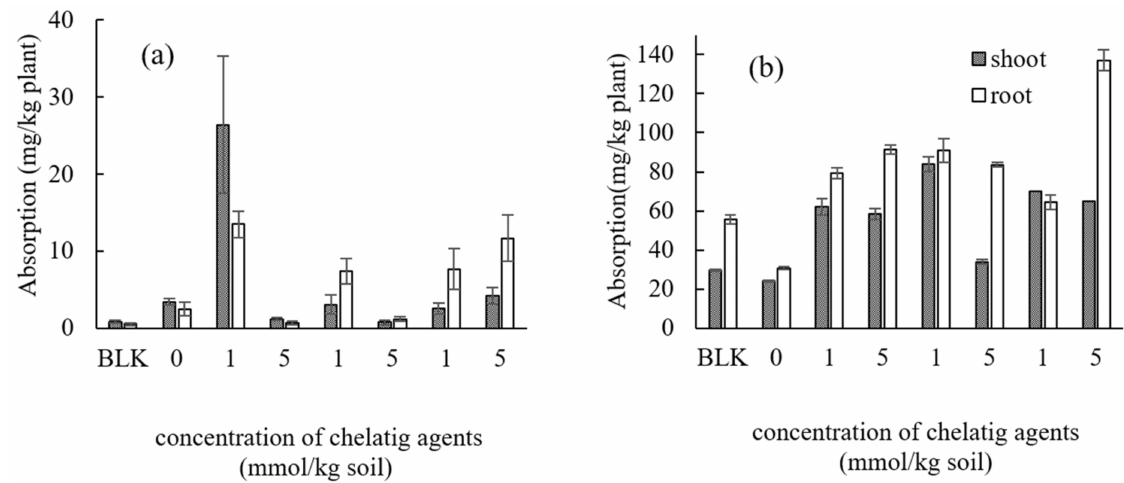
Figure 5. Effect of types and concentrations of chelating agents on the absorption of ( a ) Cd ( b ) Zn in Taraxacum officinale. The numbers represent the concentration (mmol kg − 1 ). BLK represents the pot for no addition of heavy metals (i.e., Al, Pb, Bi, and Ni) as well as no addition of chelating agents (i.e., Pot No. 1 in Table